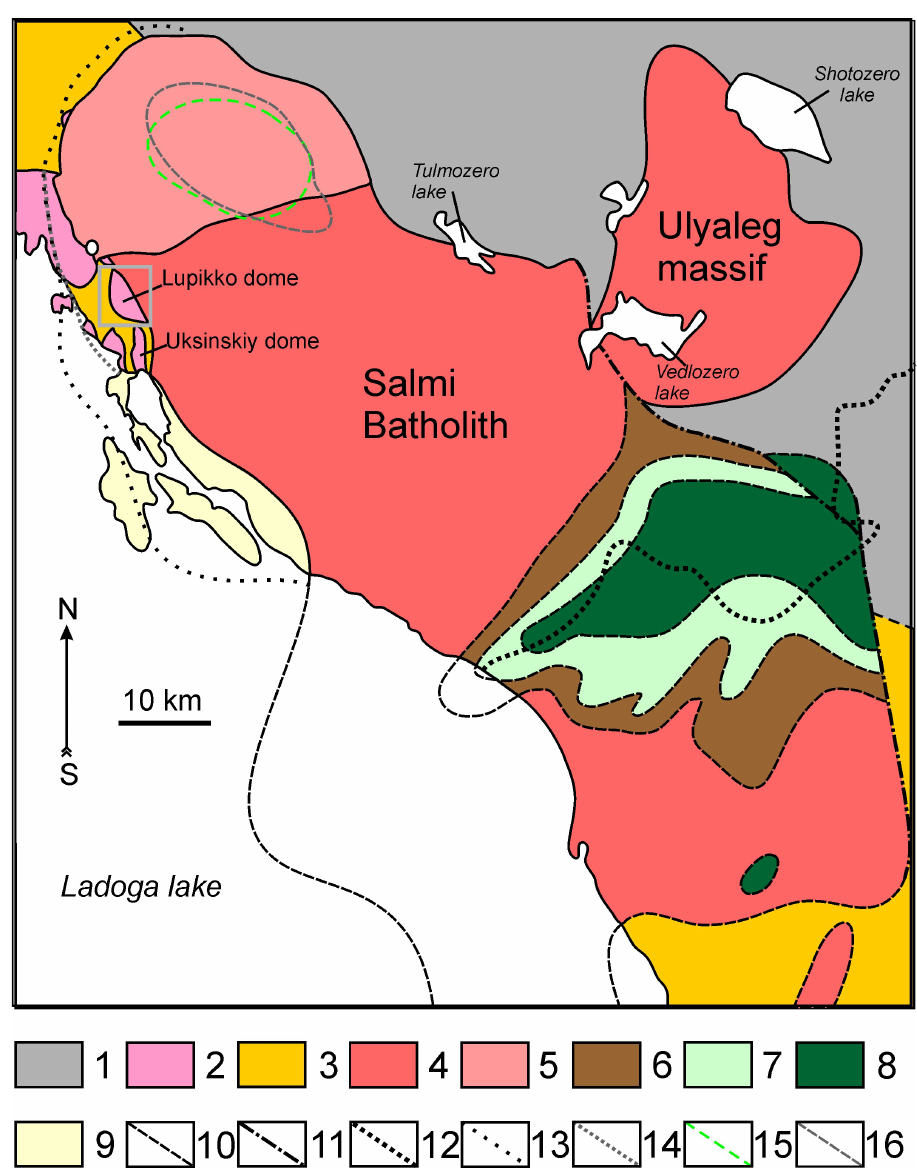
Figure 2. Simplified geological scheme of the Salmi batholith structure, compiled by the current author with consideration of the materials presented in [6,30,33–37]. Grey rectangle—area of the Lupikko dome, as shown in Figure 3. Rocks of the Karelian domain (AR 2 ): 1. granite and migmatite-granite, greenstone belts, TTG association, supracrustal complex. Rocks of the Svecofennian orogen: 2. the AR 2 -PR 1 domes are mainly gneissogranite; 3. metavulcanogenic-sedimentary rocks PR 1 (micaceous and amphibole schist of the Ladoga and Sortavala series). Intrusive rocks of the Salmi batholith: 4. pink biotite-amphibole granite; 5. pink biotite granite; 6. green biotite-amphibole granite; 7. monzonite, quartz monzonite, diorite, quartz diorite; 8. gabbro, norite, anorthosite. Sedimentary-volcanogenic rocks of the Mesoproterozoic: 9. Salminskaya series (cover basalts, tuffites, and tuff sandstones). Other: 10. assumed geological boundaries; 11. tectonic contacts; 12. the boundary of the prequaternary platform cover [38]; 13. The external contour of granite according to gravimetric data [37]; 14. line showing a sharp change in the slope of the granite roof from gentle to subvertical [35]; 15. contour of high-density rocks (probability: gabbro, gabbro-pyroxenite, peridotite) located at depths of about 1.5 km and below according to gravimetric data [36]; and 16. contour of the highest elevations of the granite intrusion’s lower surface, according to gravimetric data